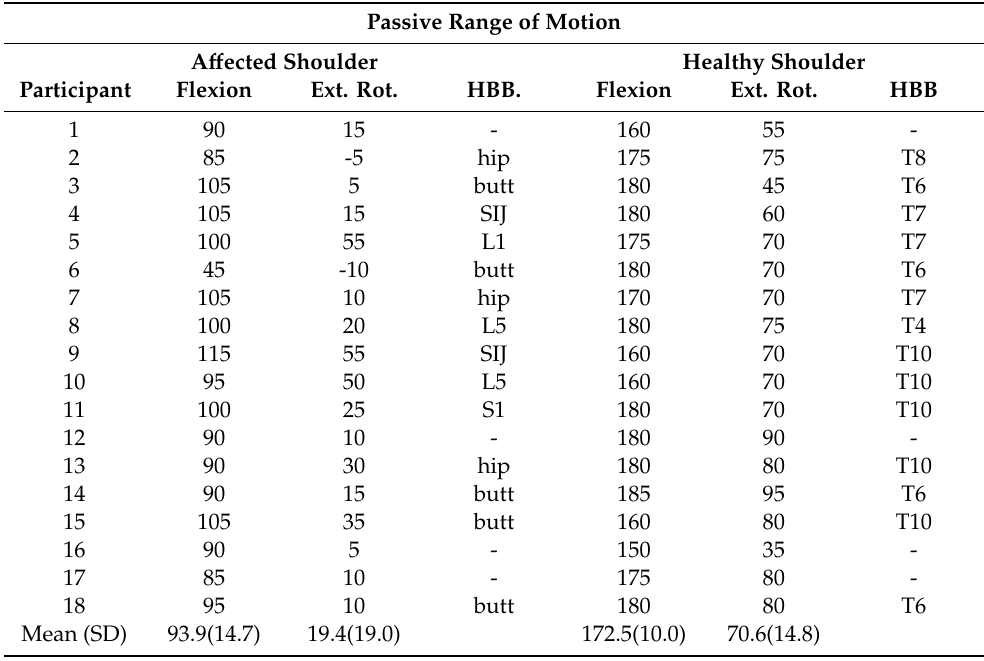
Table 2. Passive range of motion in degrees for a ff ected frozen shoulder and healthy contralateral shoulder with means and standard deviation for flexion and external rotation.